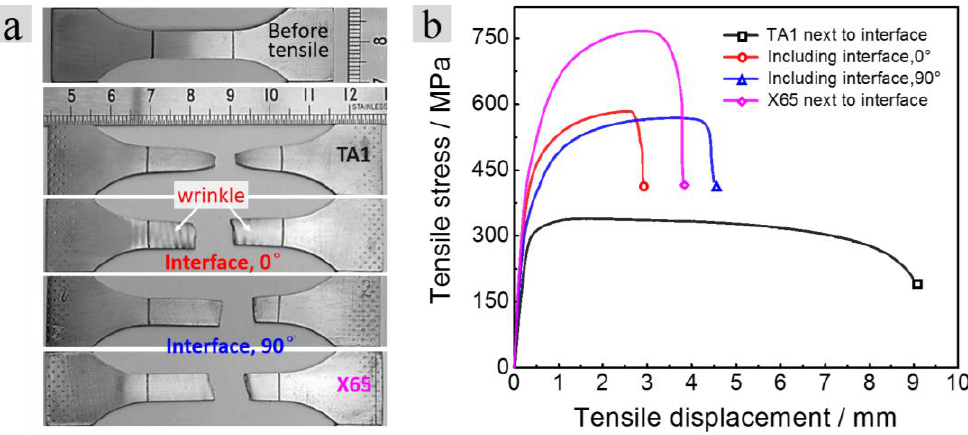
Figure 8. ( a ) Morphologies of the specimens; and ( b ) the stress-displacement curves acquired from the stratified-tensile